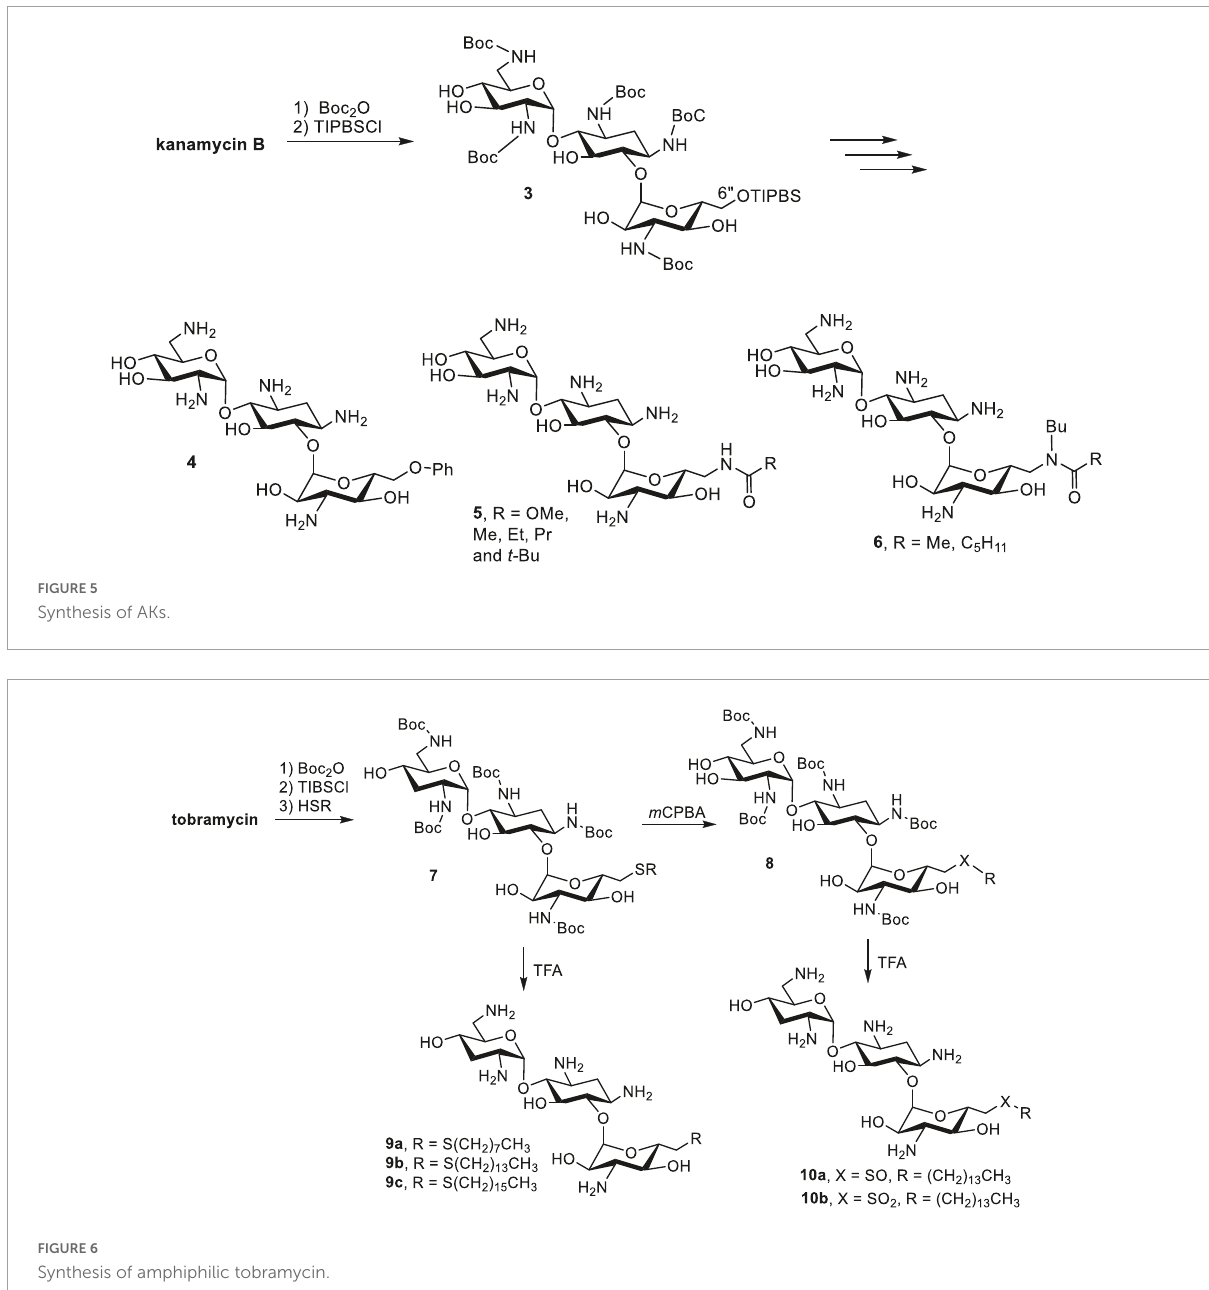
FIGURE6 Synthesis of amphiphilic